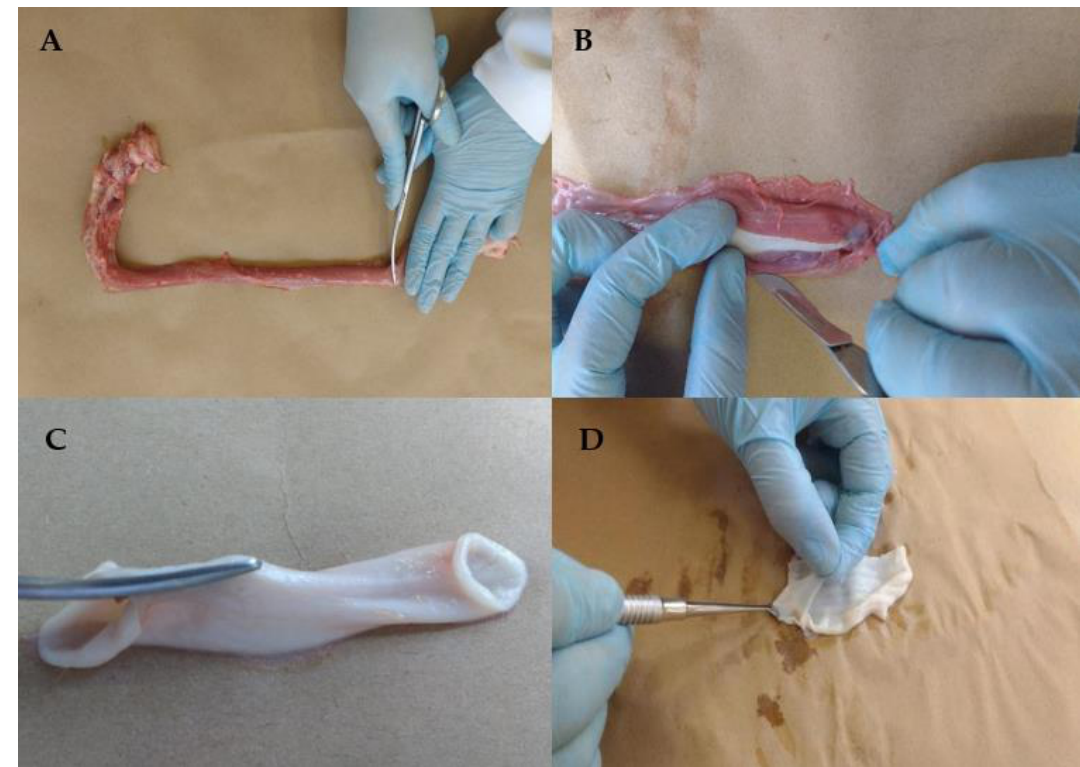
Figure 1. Esophagus mucosa preparation steps: ( A ) the ends of the esophagus were discarded; ( B ) the esophageal mucosa was gently separated from the external muscle layer with a scalpel, ( C ) the esophagi was opened longitudinally with scissors; ( D ) detachment of the epithelium from the connective tissue.